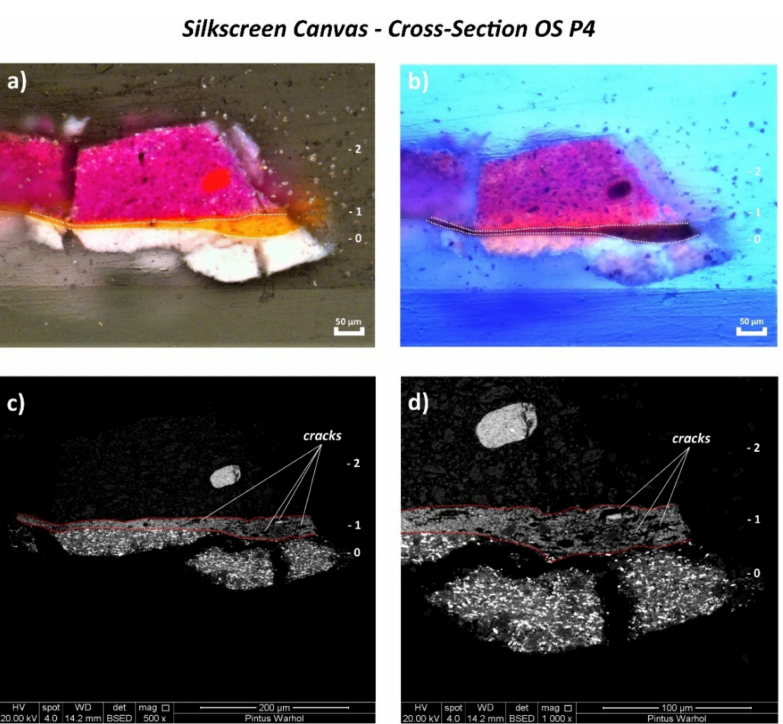
Figure 10. ( a ) Optical microscopy image of the cross-sectioned OS P4 sample under reflected visible light (Vis) showing the main layers and ( b ) under ultraviolet light (UV). ( c ) SEM micrograph of the whole cross-sectioned OS P4 sample and ( d ) detail of the area investigated by bulk area EDX analyses showing the main paint layers.